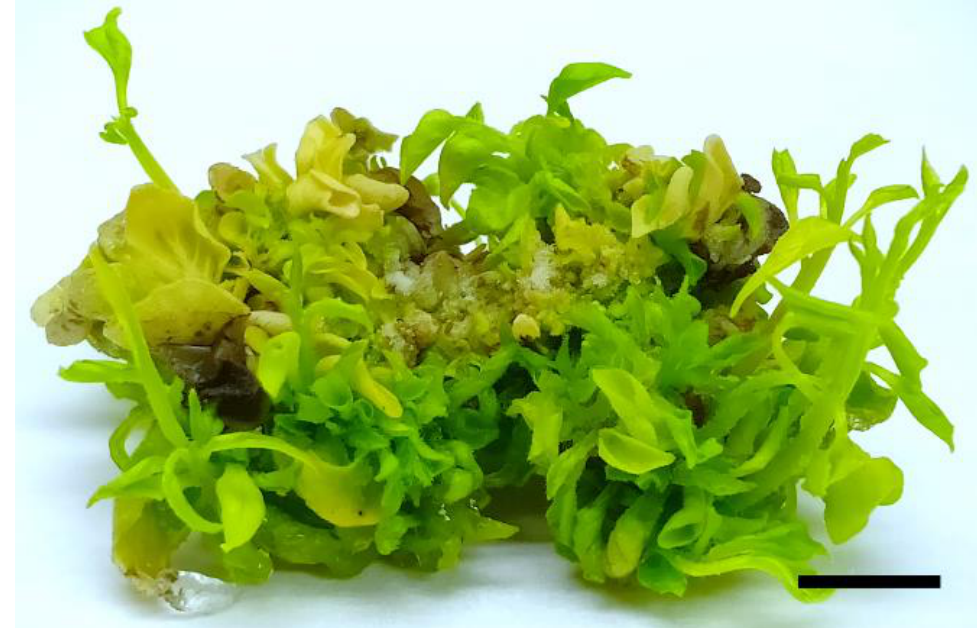
Figure 1. Differentiated Capsicum shoots obtained after two months of culture of cotyledons on Pep1 + Pep1.2 medium (Pep1: 5 mg/L BAP, 0.5 mg/L IAA and 0.47 mg/L CuSO 4 ; Pep1.2: same composition as Pep1 plus 10 mg/L AgNO 3 ). The bar for reference measures 1 cm.